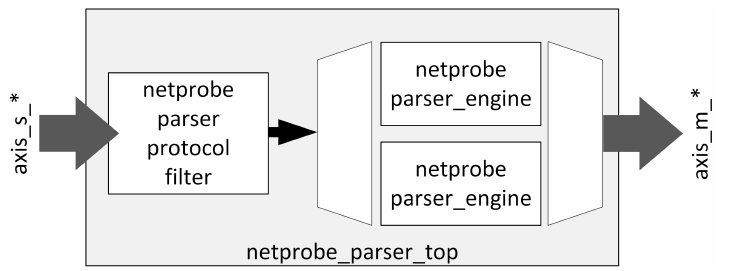
Figure 8. Block scheme of the network probe hardware accelerator packet parser module— netprobe_parser_top